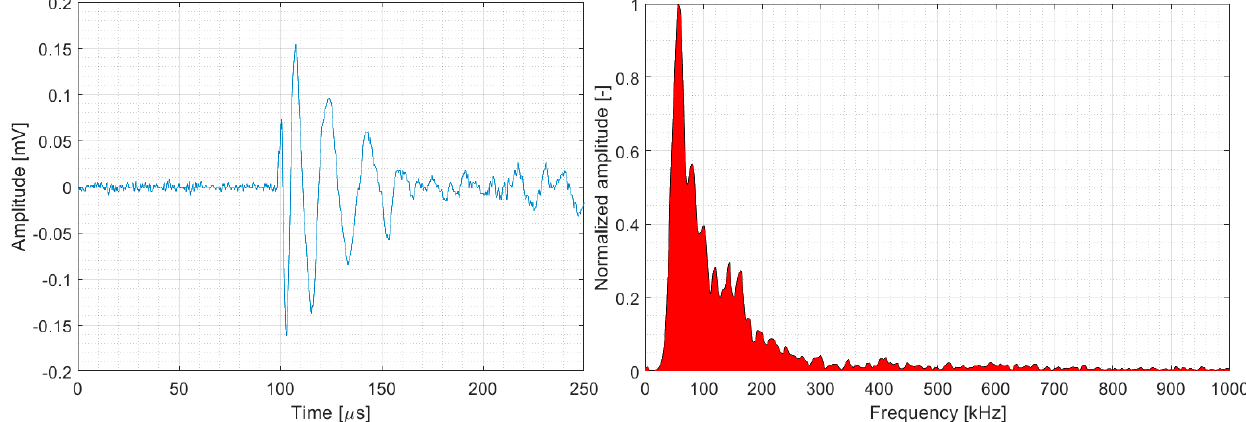
Figure 27. Representative AE signal of matrix cracking (DWC 454 dataset).